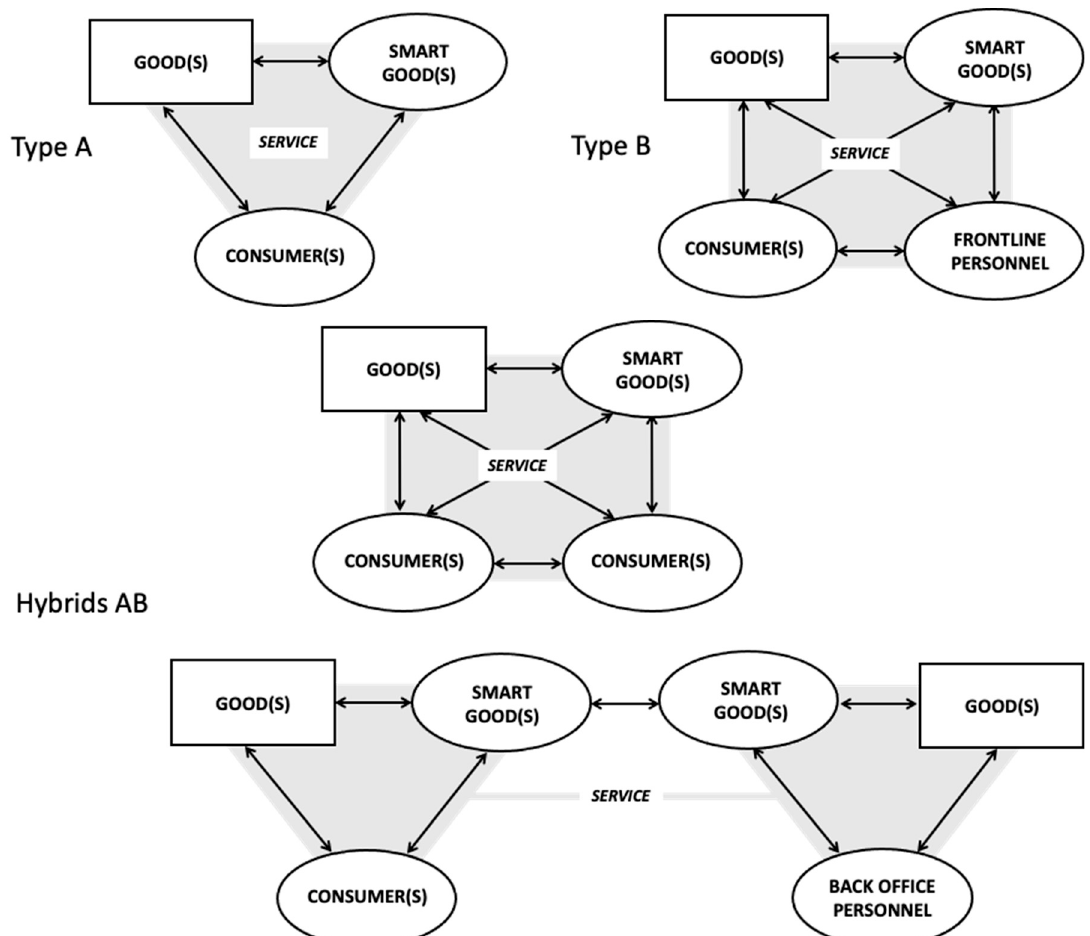
Figure 2. New consumption